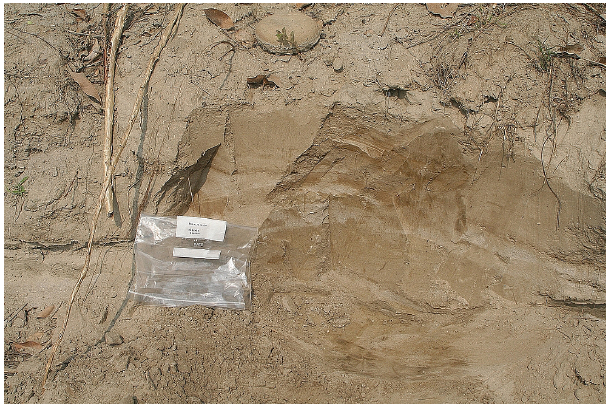
Figure A2. BG1.8 – fine-grained sand deposit ( ∼ 7m in thick- ness) corresponding to sequence of palaeo-flood deposits from last ∼ 600 years. Sample was taken 1.8m from base of exposure which has been OSL dated at 225 ± 72 years (Wasson et al., 2013).